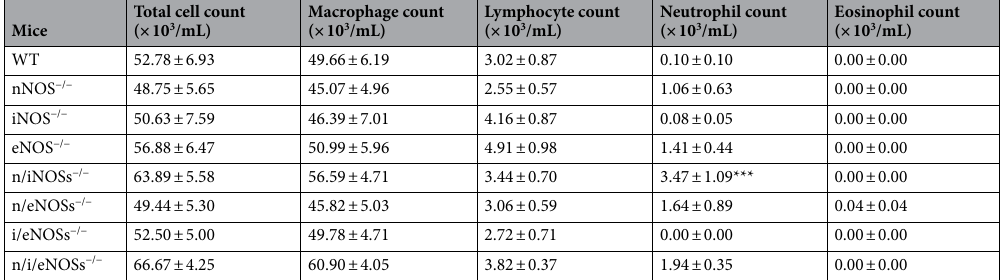
Table 1. BALF profile in WT, and single, double, and triple NOSs −/− mice. n = 8–9, *** P < 0.001 vs. WT mice.